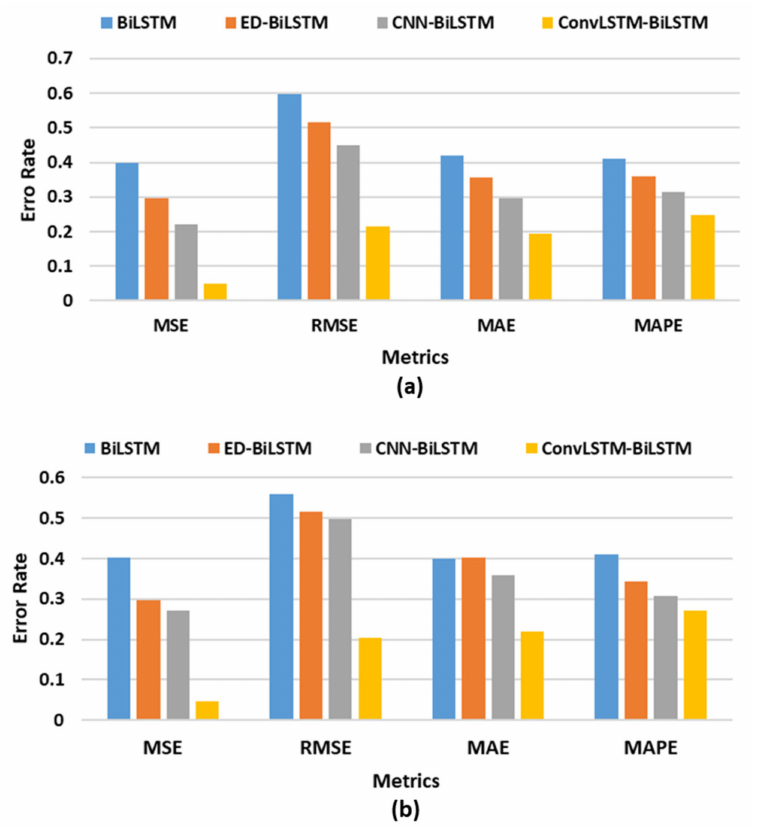
Figure 5. Average of the resolution-based error rate on hold-out validation method; ( a ) Household Dataset and ( b ) Commercial